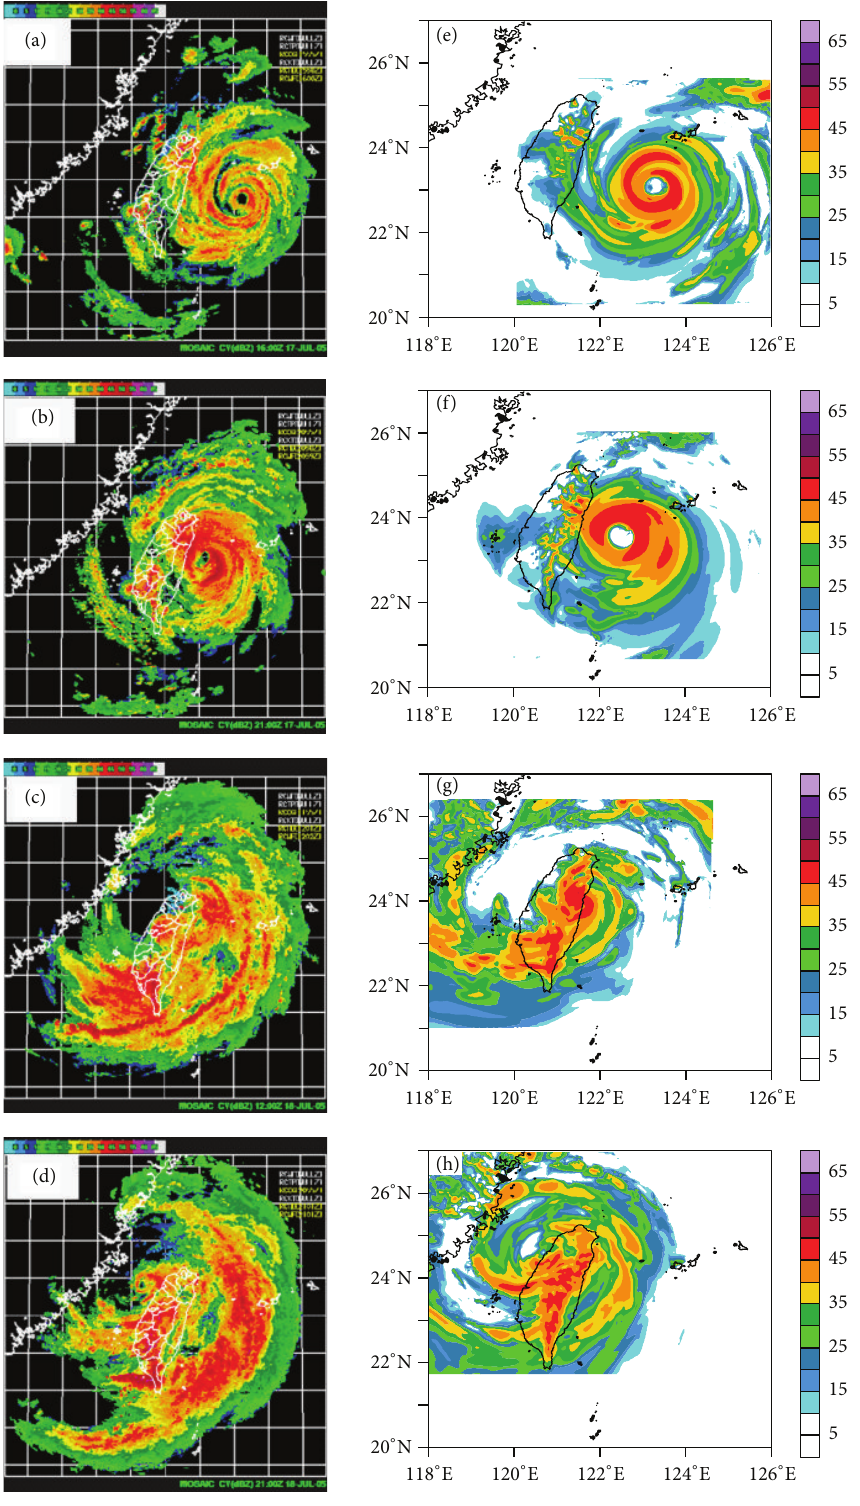
Figure 3: Radar reflectivity (unit: dbz) from Taiwan Central Weather Bureau at (a) 1600 UTC 17 July 2005, (b) 2100 UTC 17 July 2005, (c) 1200 UTC 18 July 2005, and (d) 2000 UTC 18 July 2005, and radar reflectivity (unit: dbz) from the 3 km CTRL simulation at (e) 1500 UTC 17 July 2005 (f) 2100 UTC 17 July 2005, (g) 1200 UTC 18 July 2005, and (h) 2100 UTC 18 July